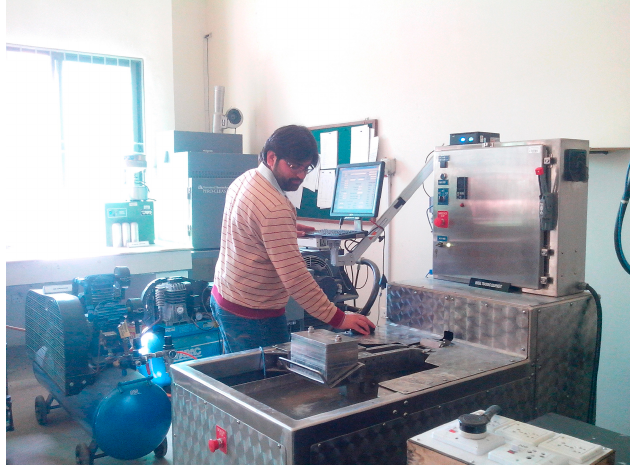
Figure 10. Specimen in water during submerged mode.